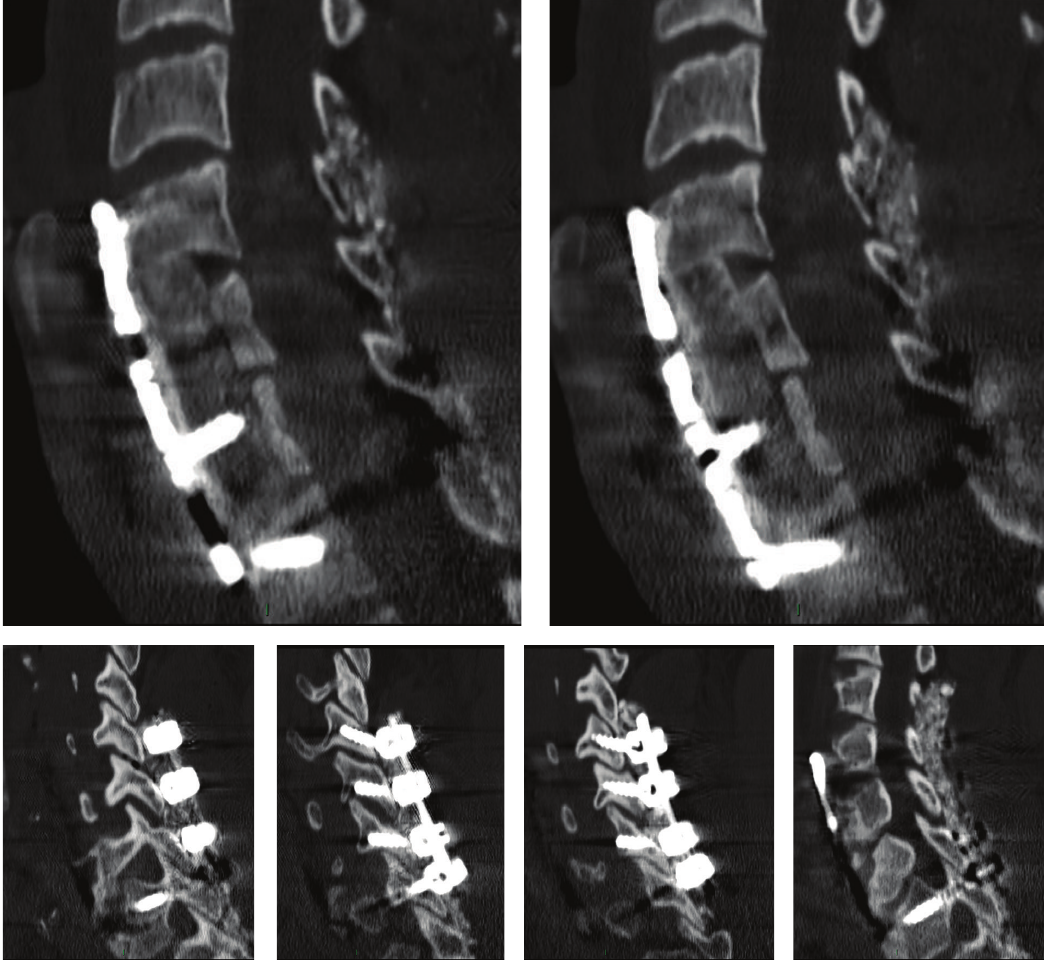
Figure 3: Postoperative CT scans showing posterior C4–C7 fixation and arthrodesis with lateral mass screwing, anterior C5-C6 corpectomy and tricortical bone grafting, and C4–C7